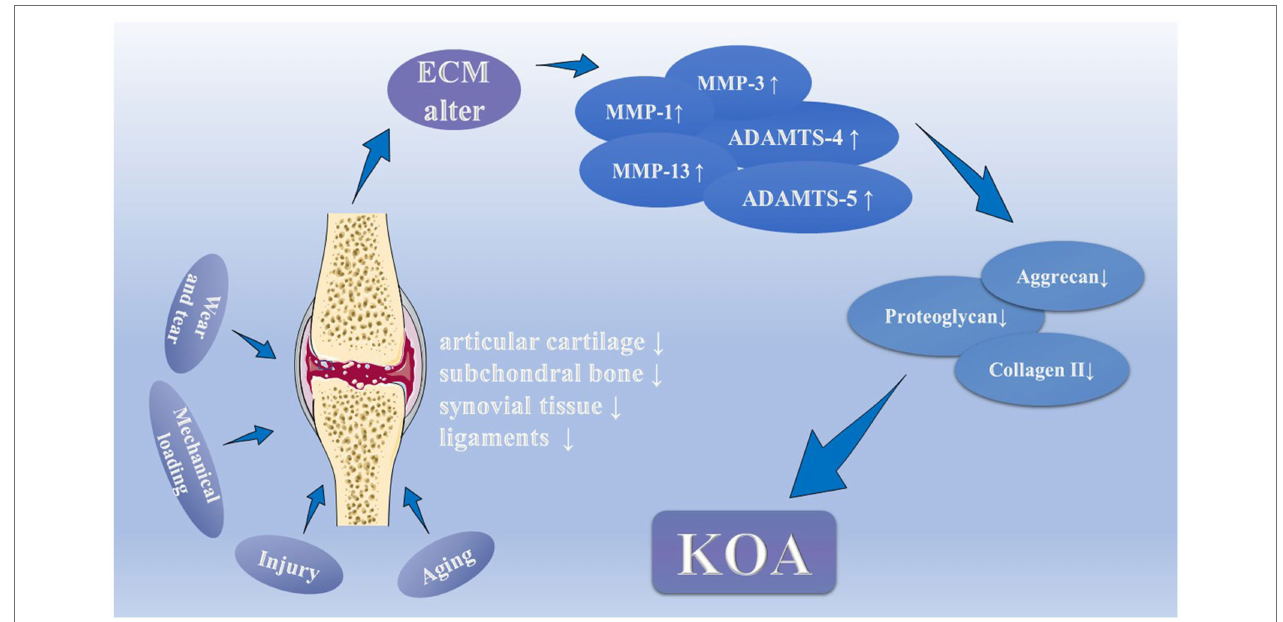
FIGURE 1 | The pathology and pathophysiology of Knee osteoarthritis (KOA). Normal wear and tear, abnormal mechanical loading, injury, and aging are common causes to damage articular cartilage, as well as subchondral bone, synovial tissue and ligaments, which could change the molecular composition and organization in the extracellular matrix. Under the stimulation, injured chondrocytes produce the matrix metalloproteinases (MMP-1, MMP-3, and MMP-13) and the ADAMTSs (ADAMTS-4 and ADAMTS-5). They thus contribute to declining levels of proteoglycans, aggrecan, and type II collagen in the cartilage matrix by inhibiting the synthesis of key components of the extracellular matrix, which eventually leads to cartilage